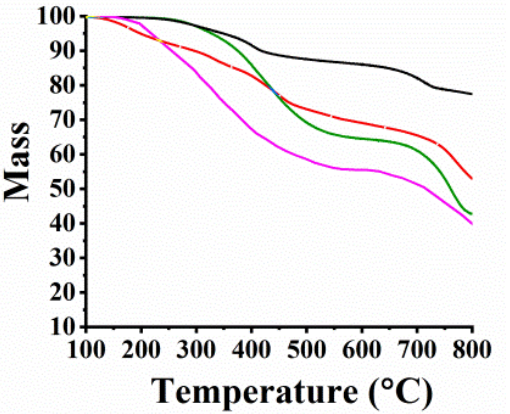
Figure 5 . TGA graphs for MoSe 2 -CoP (pink), MoSe 2 (black), f-MoSe 2 (green), and CoP (red). Steady-state electronic absorption spectroscopy provided further proof for the formation of MoSe 2 -CoP and WSe 2 -CoP (Figures 6 and S5, respectively). The absorption spectra for intact MoSe 2 and WSe 2 exhibit strong and broad absorption in the visible region without any distinct features, typical for TMDs of 1T-phase derived from bottom-up approaches [36,37]. Meanwhile, in the absorption spectrum of MoSe 2 -CoP, the Soret band at 410 nm is evident, also visible in the UV-Vis spectrum of CoP (Figure 6), whereas the band of MoSe 2 centered at 537 nm is blue-shifted at 502 nm indicating the electronic communication of MoSe 2 and CoP within MoSe 2 -CoP hybrid at the ground state. Moreover, the UV-Vis spectrum of WSe 2 -CoP (Figure S5) shows a distinct absorption band at 410 nm, deriving from the successful conjugation of f-WSe 2 with CoP.